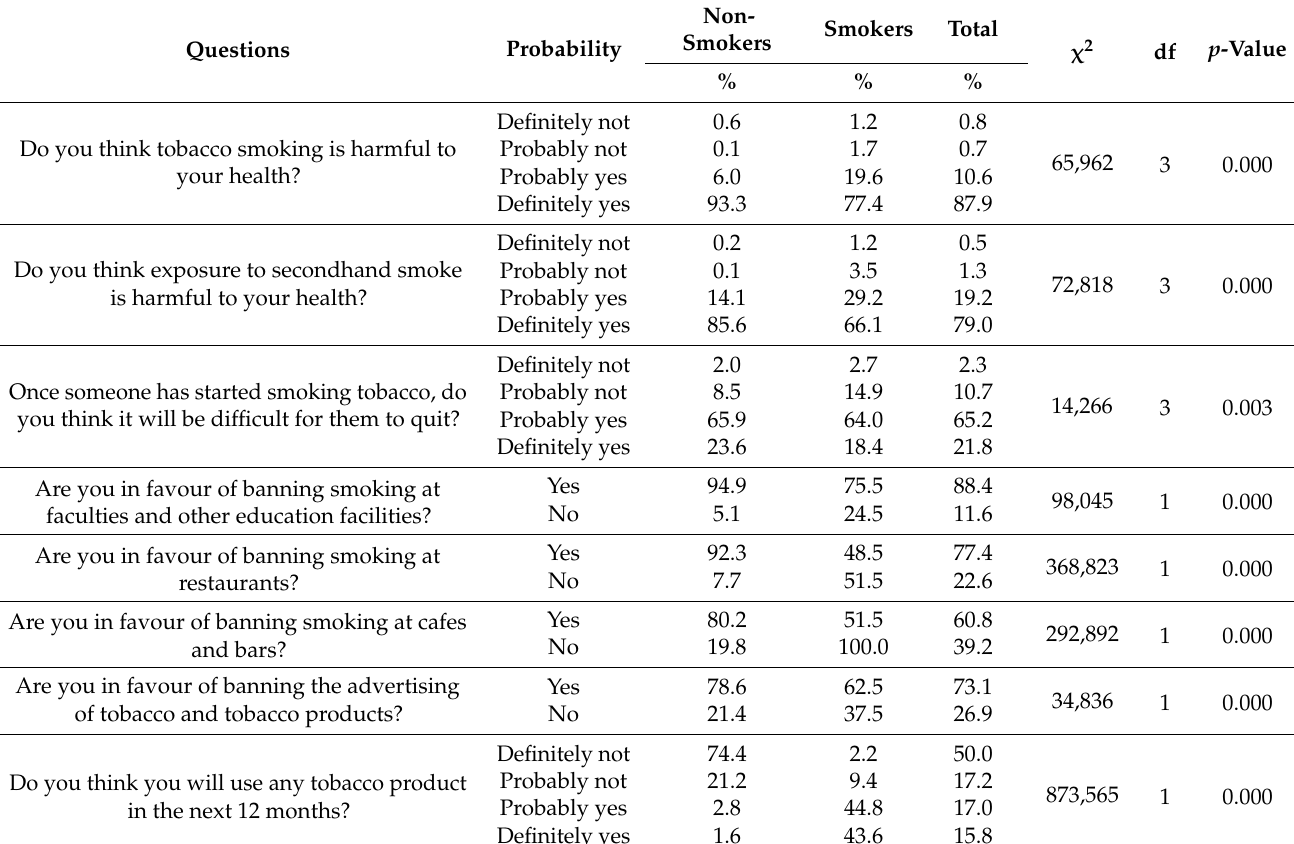
Table 4. Students’ attitudes concerning tobacco use and exposure to secondhand